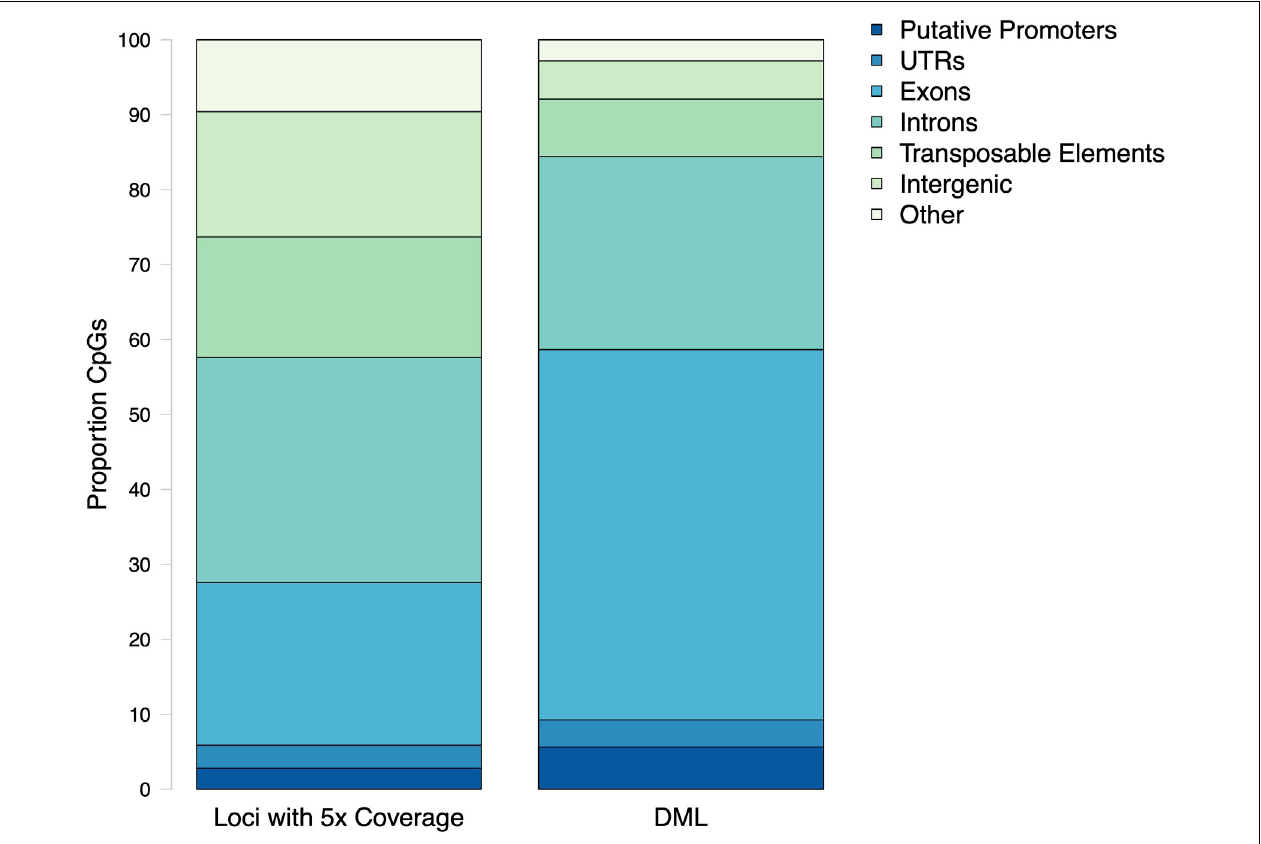
FIGURE 6 | Proportion CpG loci within putative promoters, untranslated regions (UTR), exons, introns, transposable elements, and intergenic regions for MBD-enriched CpGs and differentially methylated loci (DML). The distribution of DML in C. virginica gonad tissue in response to ocean acidification differed from distribution of MBD-enriched loci with 5 × coverage across control and treatment samples (Contingency test; χ 2 = 401.09, df = 6, P -value <